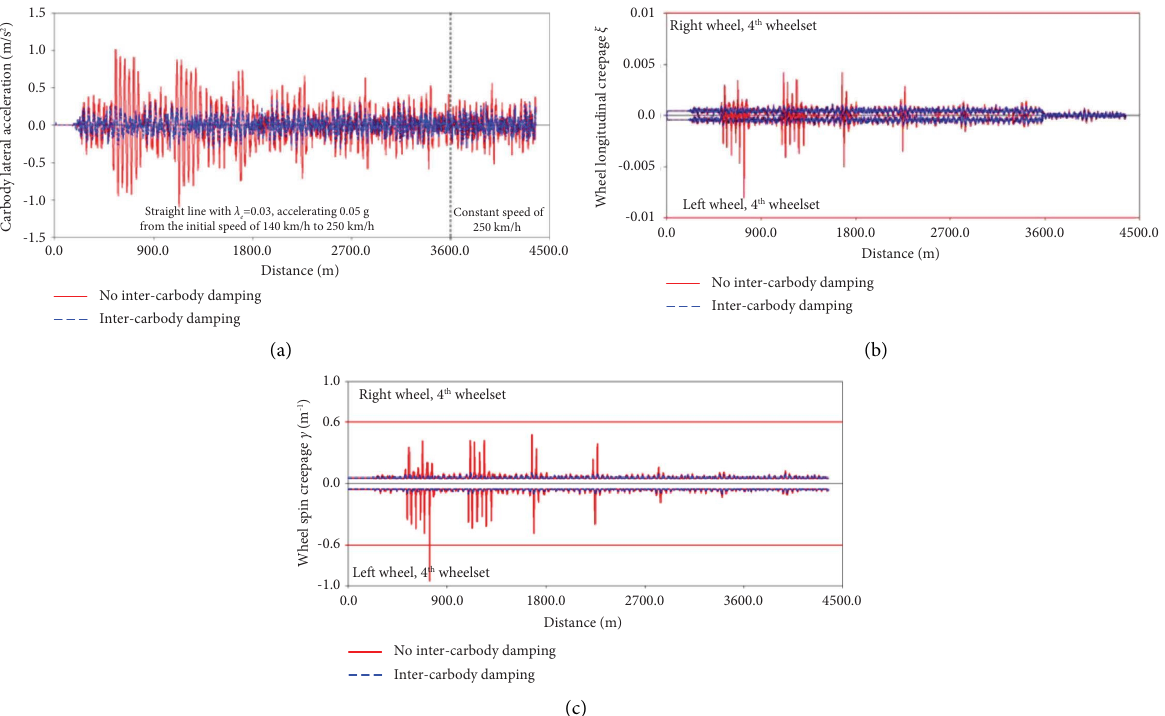
Figure 7: Efective assessments of MC03 under a curving negotiation condition of R3000m/superelevation 100mm and a velocity of 160km/h. (a) Lateral acceleration contrast at the rear-right point on the car body foor. (b) Distribution contrast of wheel wear index characteristics when intervehicle damping is of. (c) Distribution contrast of wheel wear index characteristics when intervehicle damping is on.